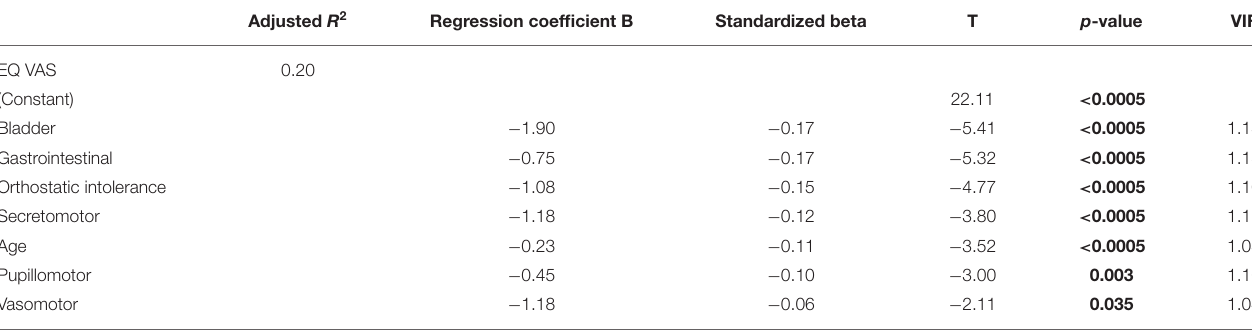
TABLE 2 | Autonomic symptoms and Health-Related Quality of Life: model without BDI-I.